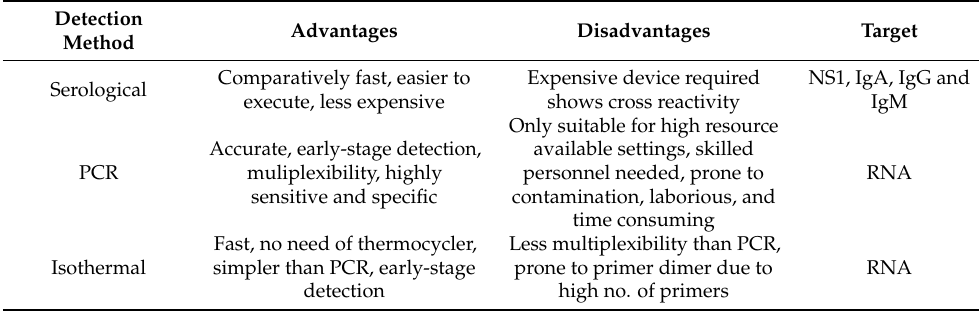
Table 3. Advantages and disadvantages of conventional methods for the detection of dengue (Reused with permission from Biosensors, MDPI